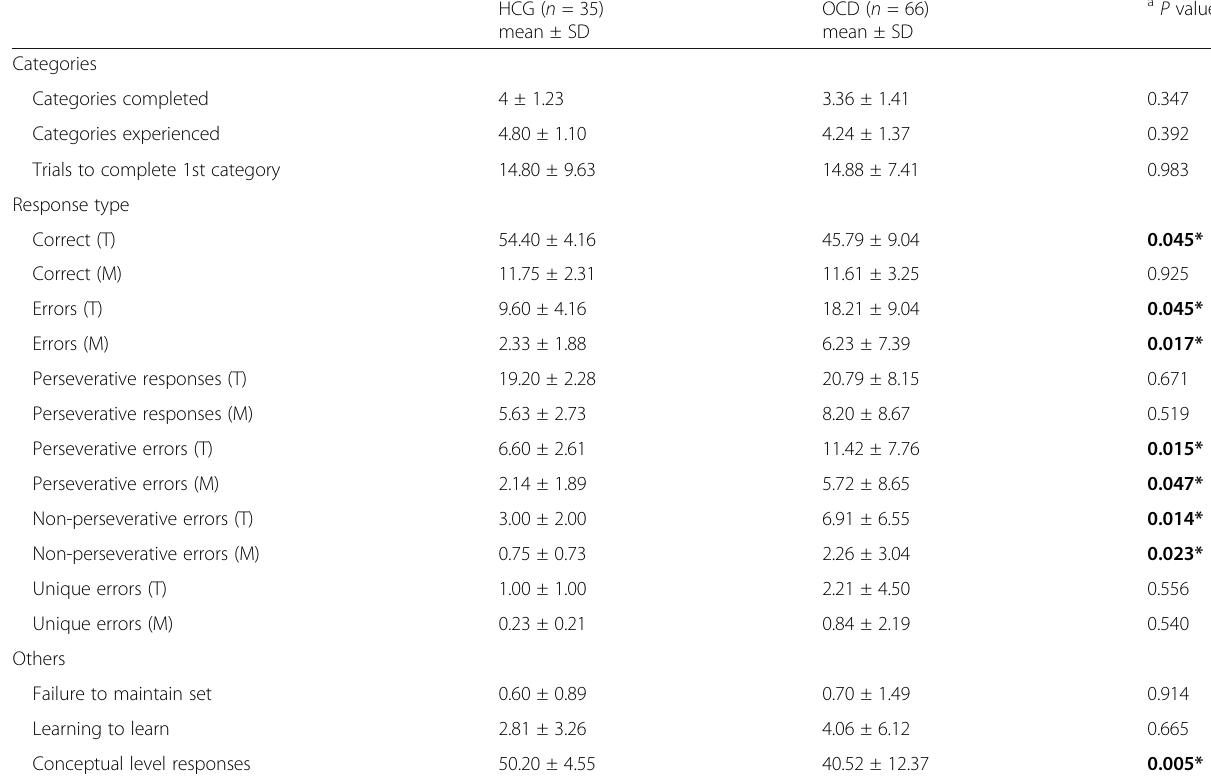
Table 3 WCST indices (categories, response type, others) among the studied participants ( n = 101)